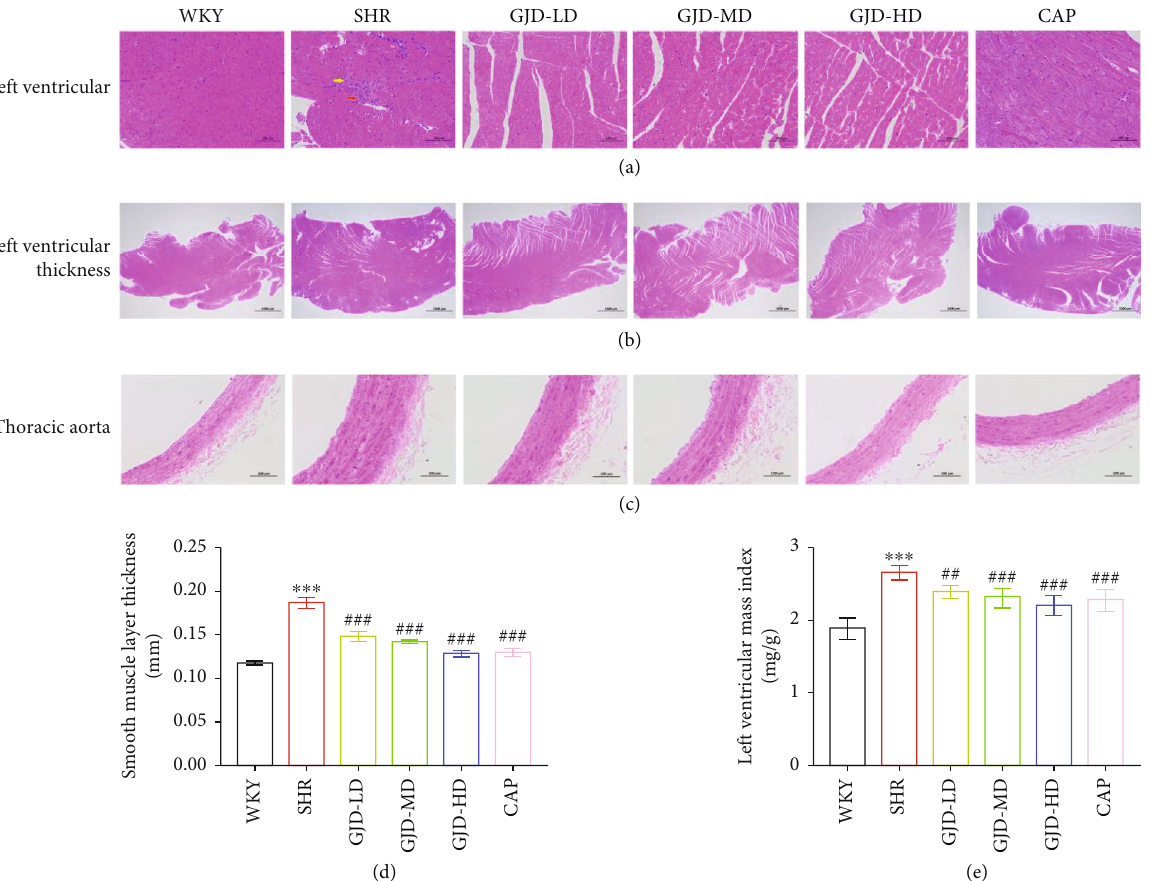
Figure 9: E ff ect of GJD on cardiovascular remodeling and histology of left ventricular and thoracic aorta of SHR after 6-week treatment by GJD. (a) HE staining Left ventricular (magni fi cation of × 200, scale bar 100 μ m). (b) Ventricular wall (magni fi cation of × 20, scale bar 1000 μ m). (c) HE staining of thoracic aorta (magni fi cation of × 200, scale bar 100 μ m). (d) Smooth muscle layer thickness. (e) LVMI. Partial myocardial fi brosis necrolysis was replaced by hyperplastic connective tissue (yellow arrows) with punctate lymphocytic in fi ltration (red arrows) in the SHR group. WKY indicates the WKY control group, SHR indicates the SHR model group, GJD-LD indicates the SHR treated with GJD at a low dose, GJD-MD indicates the SHR treated with GJD at a medium dose, GJD-HD indicates the SHR treated with GJD at a high dose, and CAP indicates SHR treated with captopril. Data are means ± SD , n = 7 . ∗ P < 0 : 05 , ∗∗ P < 0 : 01 , ∗∗∗ P < 0 : 001 vs. WKY group. # P < 0 : 05 , ## P < 0 : 01 , ### P < 0 : 001 vs. SHR